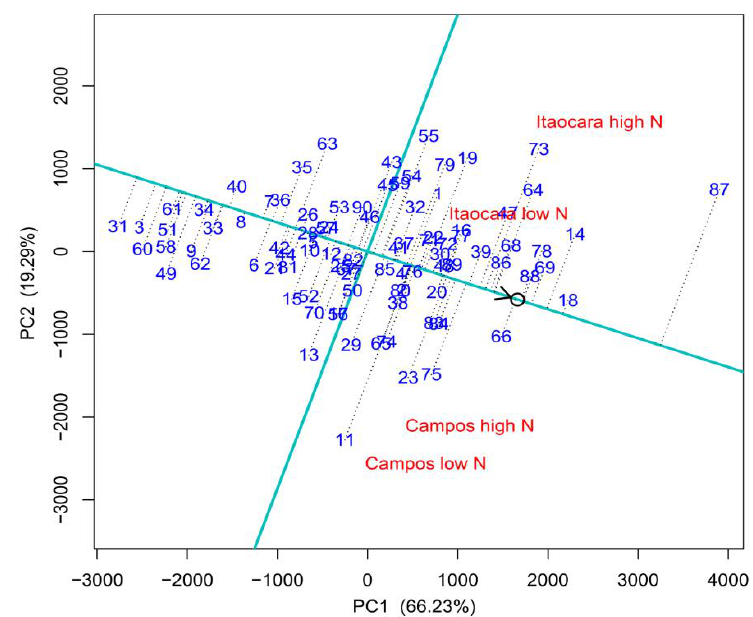
Figure 2. Adaptability and stability regarding grain yield of 90 popcorn hybrids in environments with low and ideal N availability.